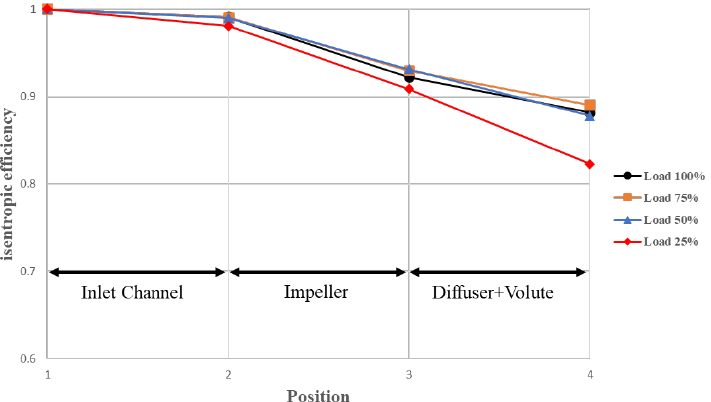
Figure 13. Second stage isentropic compression efficiency with R-513A refrigerant in various flow element configurations.